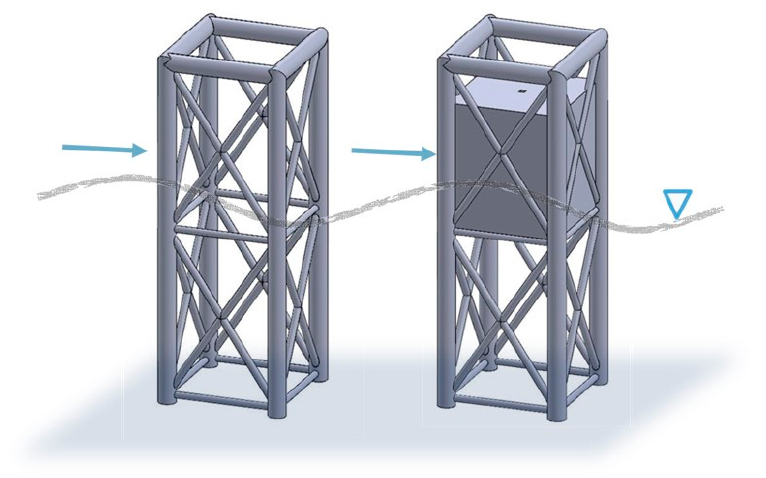
Figure 1. Schematic drawing of a jacket type structure installed with OWC converter.